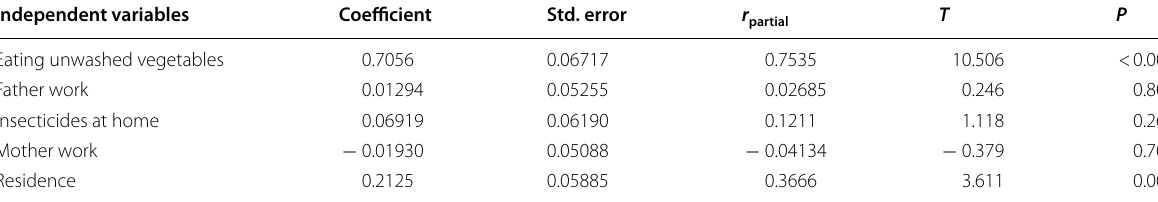
Table 6 Multiple regression test to assess risk factors for ChE deficiency Independent variables Coefficient Std. error r